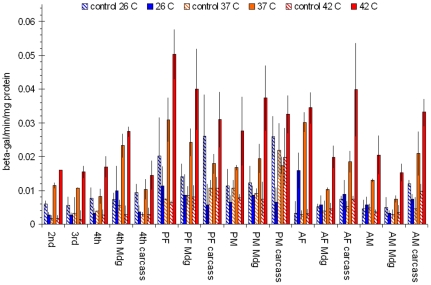
Induction of β-gal activity by heat shock in F0 from eggs of pXH70ZT/PEI microinjected vitellogenic females.Mdg =  the midgut samples; carcasses = the body wall samples; 2nd =  2nd instar; 3rd =  3rd instar; 4th =  4th instar; PF =  female pupae; PM =  male pupae; AF =  adult females; AM =  adult males. Bars =  mean± S.D. (N = 3).